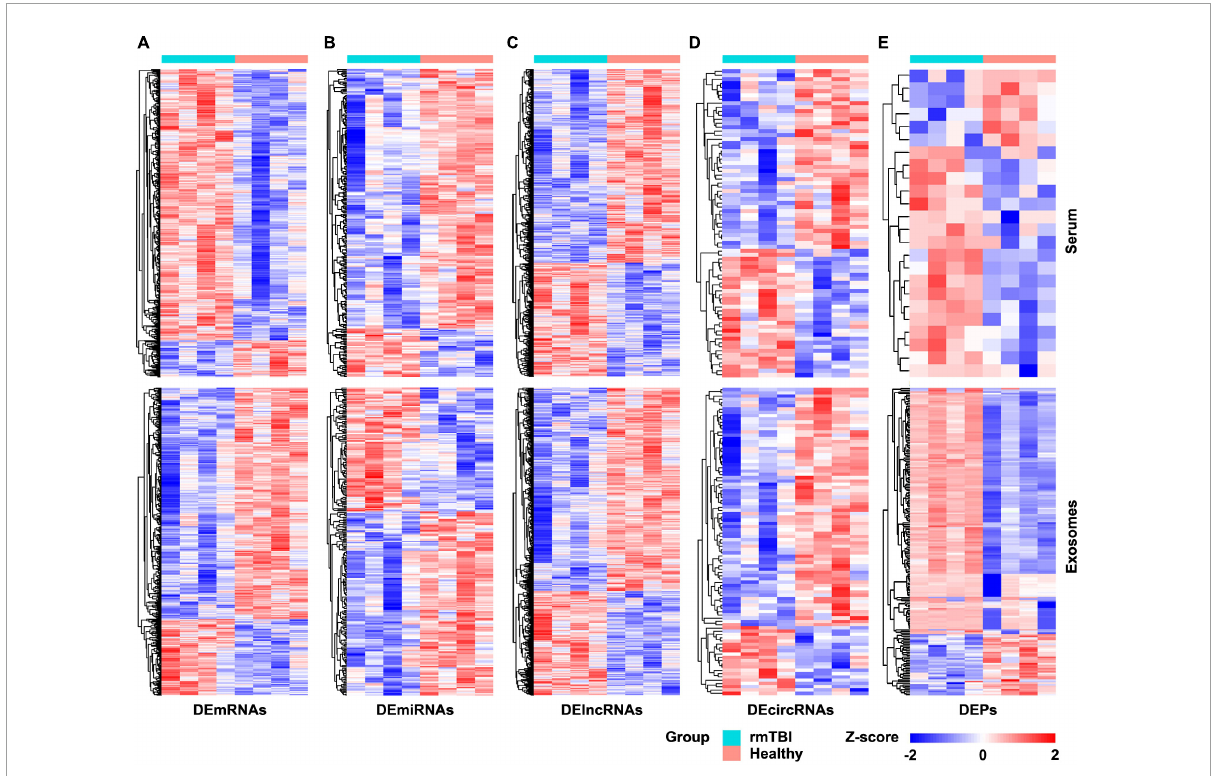
FIGURE1 Heatmap of DERNAs and DEPs in serum and exosomes between patients with rmTBI and healthy subjects. (A) DEmRNAs in serum and exosomes. (B) DEmiRNAs in serum and exosomes. (C) DElncRNAs in serum and exosomes. (D) DEcircRNAs in serum and exosomes. (E) DEPs in serum and exosomes. Up-regulated genes are shown in red, and down-regulated genes are shown in blue. DE, differentially expressed; DEPs, differentially expressed proteins.